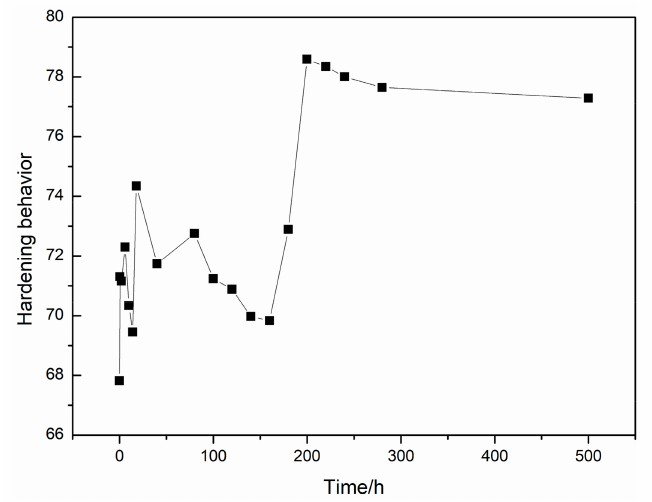
Figure 2. Age hardening curve for alloy aged at 240 ◦ C.